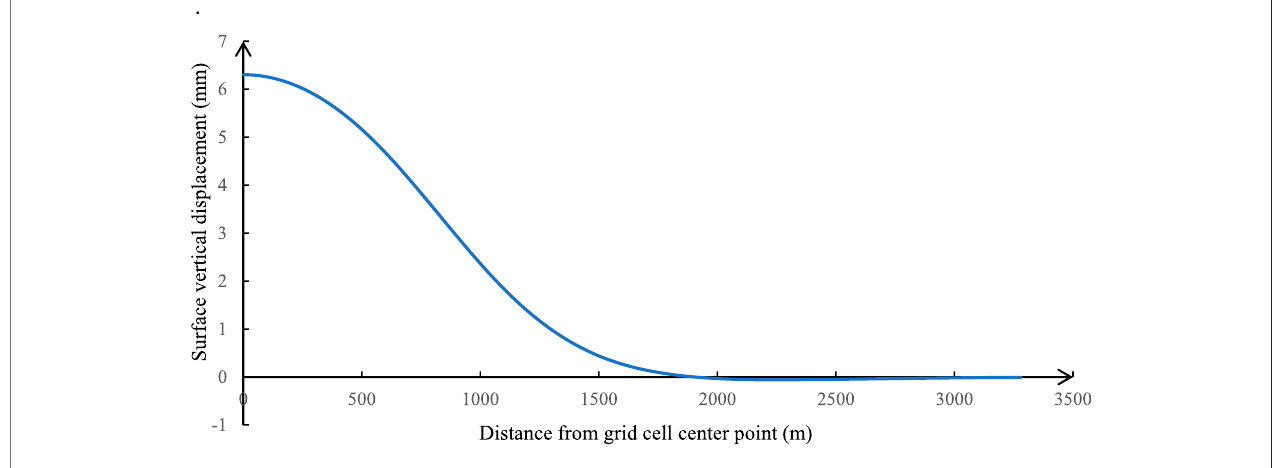
FIGURE 8 | Relationship between surface displacement and pressure difference in per-unit